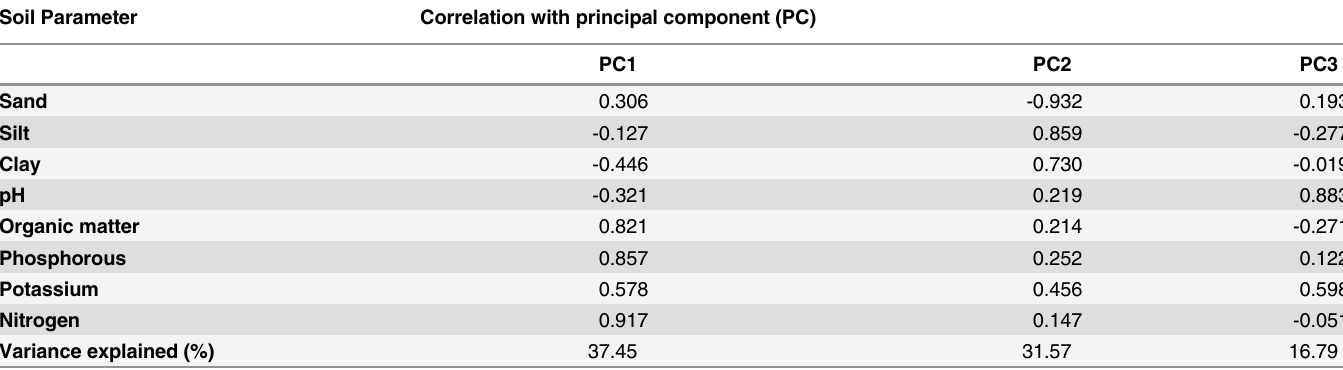
Table 2. Principal components analysis of soil texture and chemical composition parameters, conducted on the correlation matrix of soil parame- ters from sampled owl nests and the corresponding control sites (N =